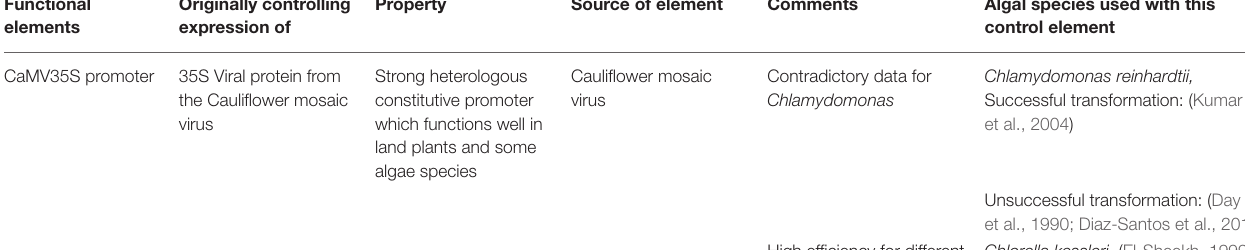
TABLE 2 | Commonly used nuclear control elements for constitutive or inducible transgene expression. Functional